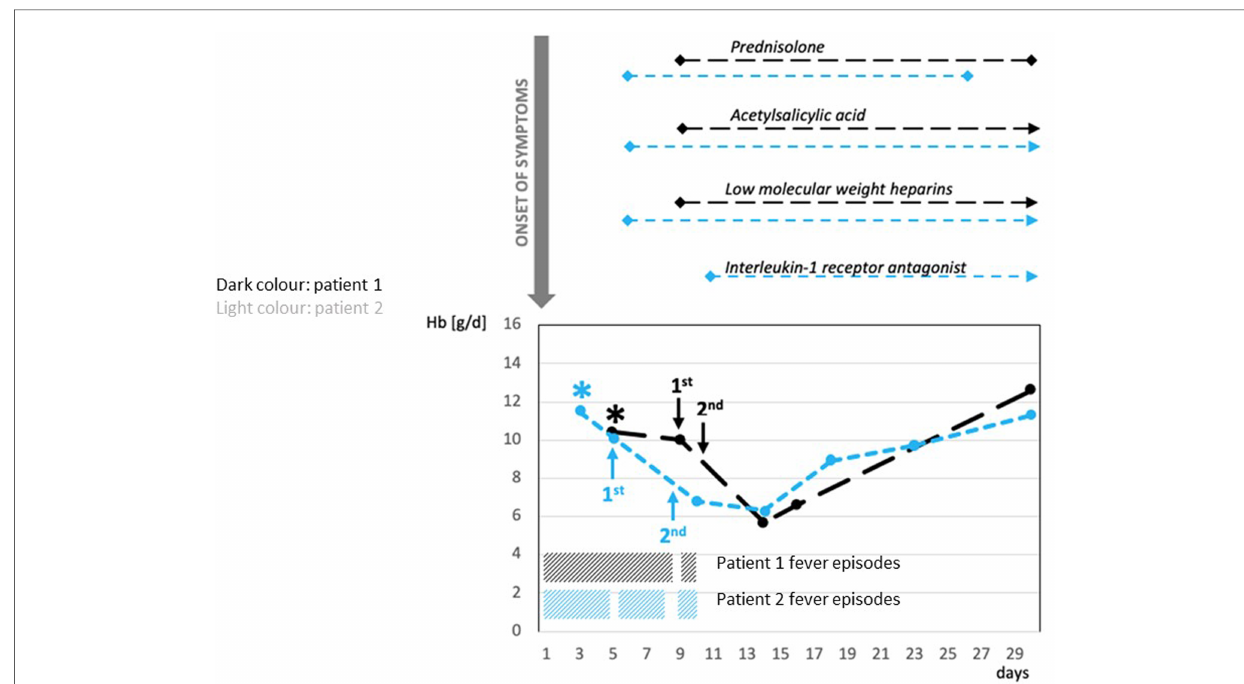
FIGURE 1 Correlation between administration of IVIG and severe hemolytic anemia: time course of Hb, treatment of PIMS-TS, and recurrent fever episodes. *admission to hospital; Prednisolone (2 mg/kg/day): Patient 1 and Patient 2 for 3 weeks; Acetylsalicylic acid (5 mg/kg b.w./day): Patient 1 for 10 months, Patient 2 for 5 weeks; Low-molecular-weight heparins (1 mg/kg b.w./d): Patient 1 for 3 weeks, Patient 2 for 5 weeks; Interleukin-1 receptor antagonist (anakinra — 100 mg subcutaneously/3 times/week): Patient 2 for 4 weeks. Patient 1: fi rst administration of IVIG 2 g/kg — 9 days after onset of PIMS-TS; second administration of IVIG 2 g/kg about 40 h after the fi rst administration. Patient 2: fi rst administration of IVIG 2 g/kg 5 days after onset of PIMS-TS; second administration of IVIG 2 g/kg 4 days after the fi rst administration. PIMS-TS, pediatric in fl ammatory multisystem syndrome temporally associated with SARS-CoV2; IVIG, intravenous immunoglobulin; Hb,